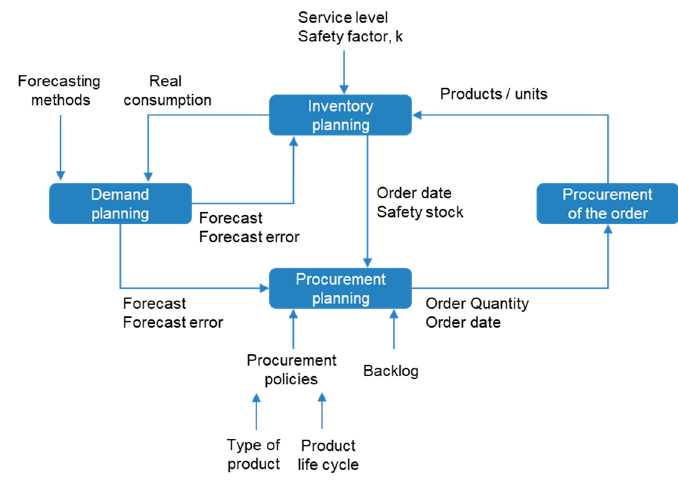
Figure 2. Conceptual framework for a market-oriented procurement (own elaboration).